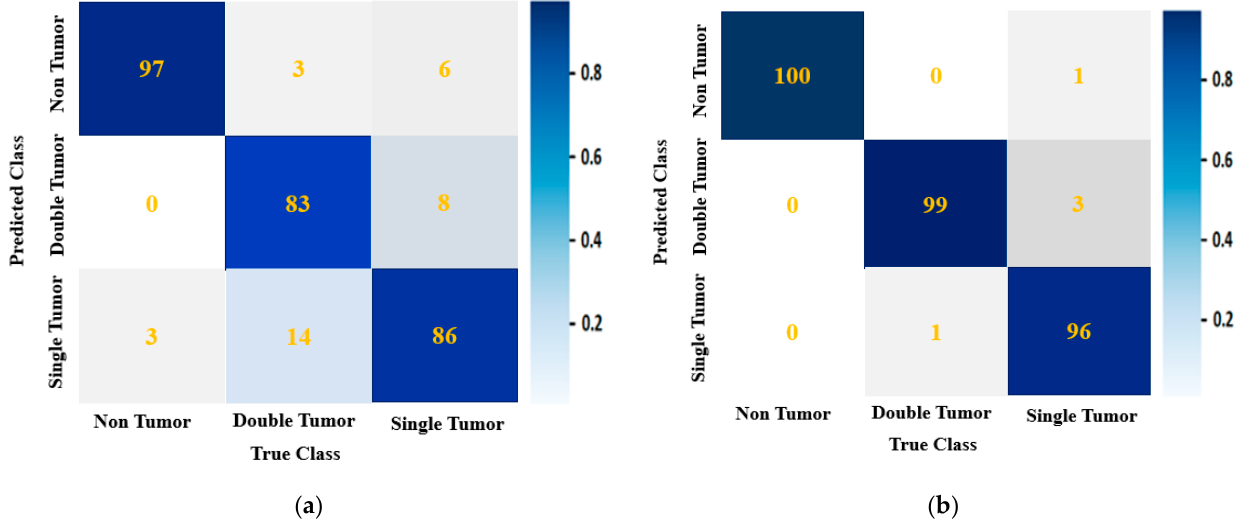
Figure 15. The confusion matrix of the proposed BINet classification model for: ( a ) the raw RMW brain images and ( b ) the segmented RMW brain images.